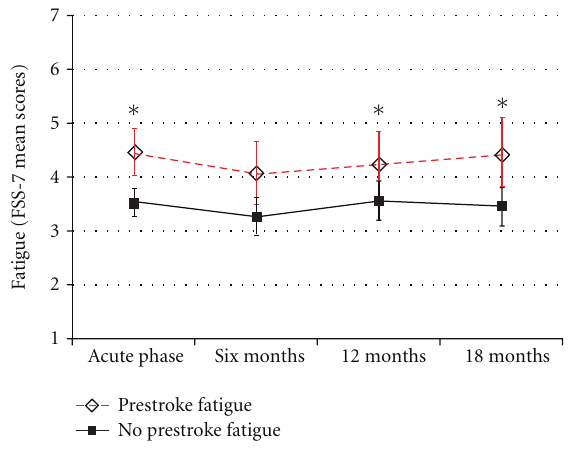
Figure 4: Time course for fatigue by patients with no prestroke fati- gue ( n = 69) and those with prestroke fatigue ( n = 26). Adjusted for level of physical functioning and depressive symptoms. Bars are lower and upper 95%